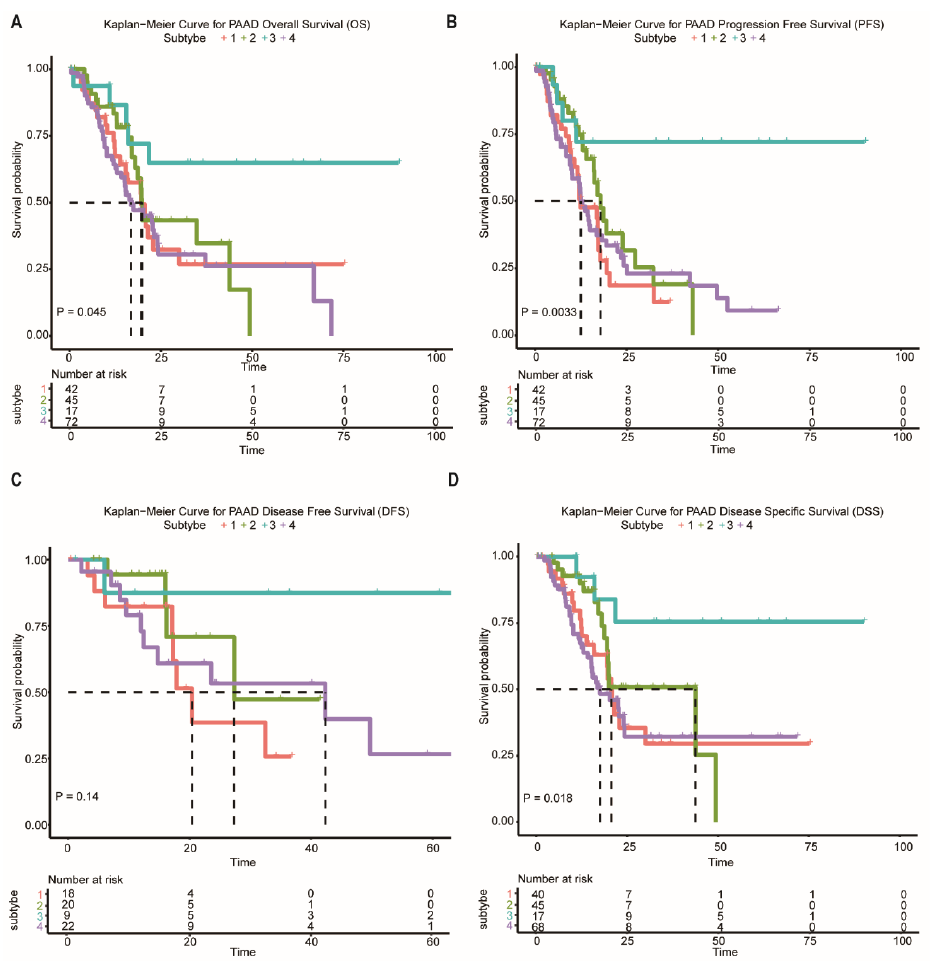
Figure 4. Survival curves of the network ‐ based subtypes. ( A – D ) Kaplan–Meier curves for the OS, PFS, DFS, and DSS of TCGA pancreatic cancer samples showed that subtype ‐ 3 had a better outcome compared with the patients in other subtypes. Abbreviations: OS, overall survival; PFS, progression ‐ free survival; DFS, disease ‐ free survival; DSS, disease ‐ specific survival; TCGA, The Cancer Genome Atlas; PAAD, pancreatic